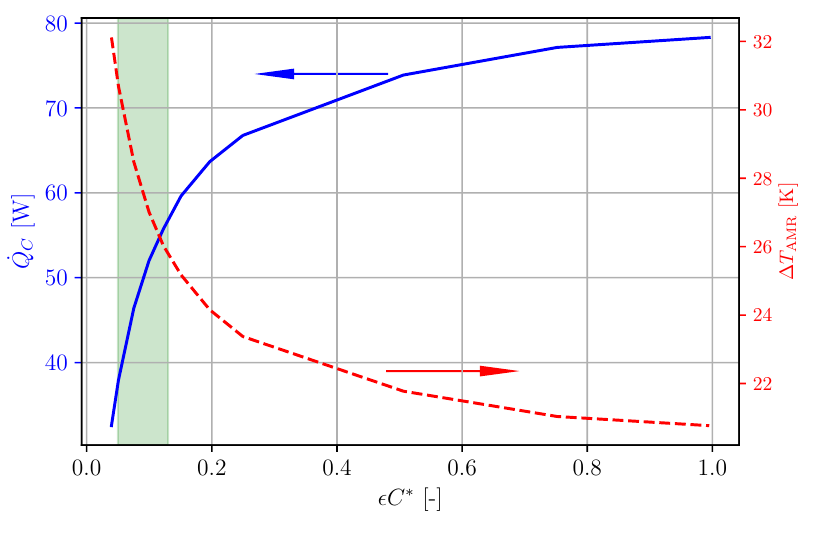
Figure 10. Influence of the heat exchanger effectiveness on the AMR cooling capacity and temperature span for a system temperature span of 20 ◦ C. The green band corresponds to the range of ε C ∗ resulting from the operating points of the heat exchangers/fan assemblies tested in this